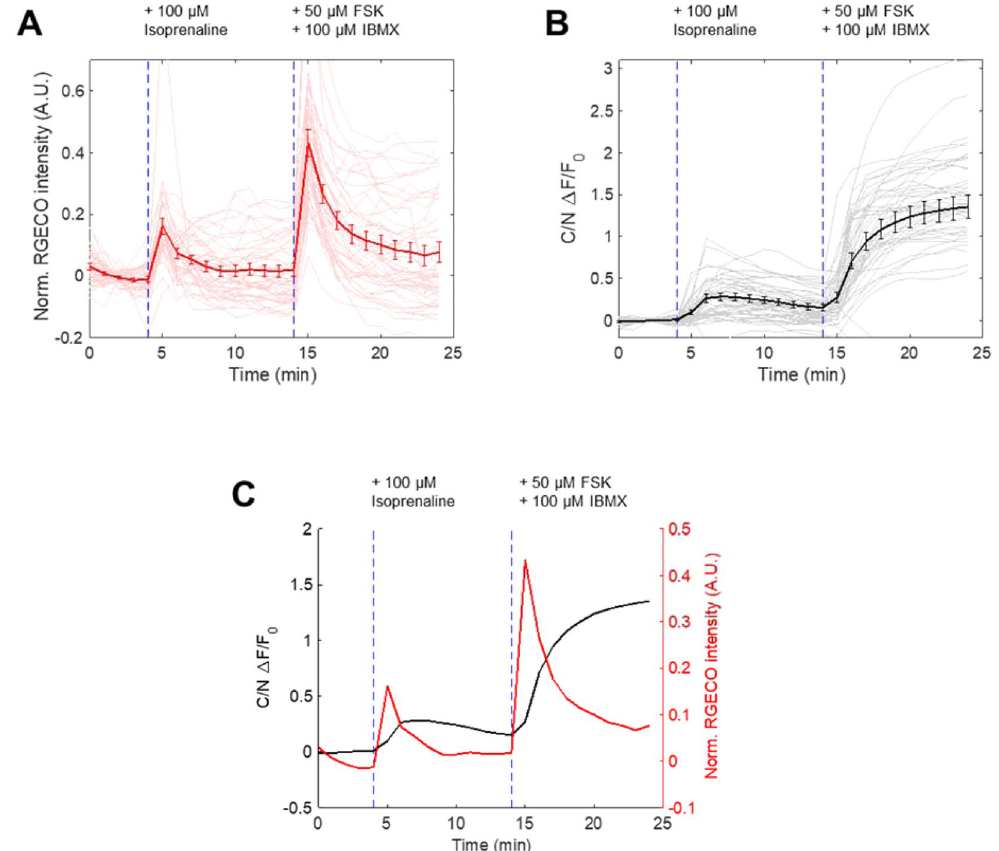
Figure 6. Duplex monitoring of Ca2 + and PKA in cells followed by isoprenaline and FSK/IBMX treatment. ( A ) Ca 2 + response as reported by R-GECO to isoprenaline (100 μ M, Sigma-Aldrich, I5627-5G) and FSK/IBMX treatment in cells also expressing PKA kinase reporter and nucleus marker. (N = 3 experiments, 48 cells) ( B ) Nuclear-cytosol translocation response of PKA kinase reporter in same cells in ( A ). ( C ) Duplex monitoring of Ca 2 + and PKA activity from (A) and